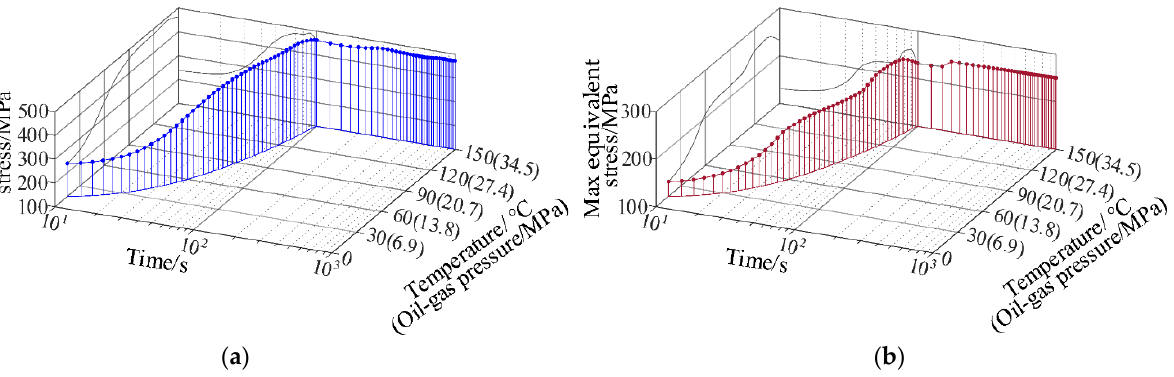
Figure 6. Variations of maximum contact stress and maximum equivalent stress of LSG under the working condition of temperature–pressure rise. ( a ) Maximum contact stress; ( b ) maximum equivalent stress.